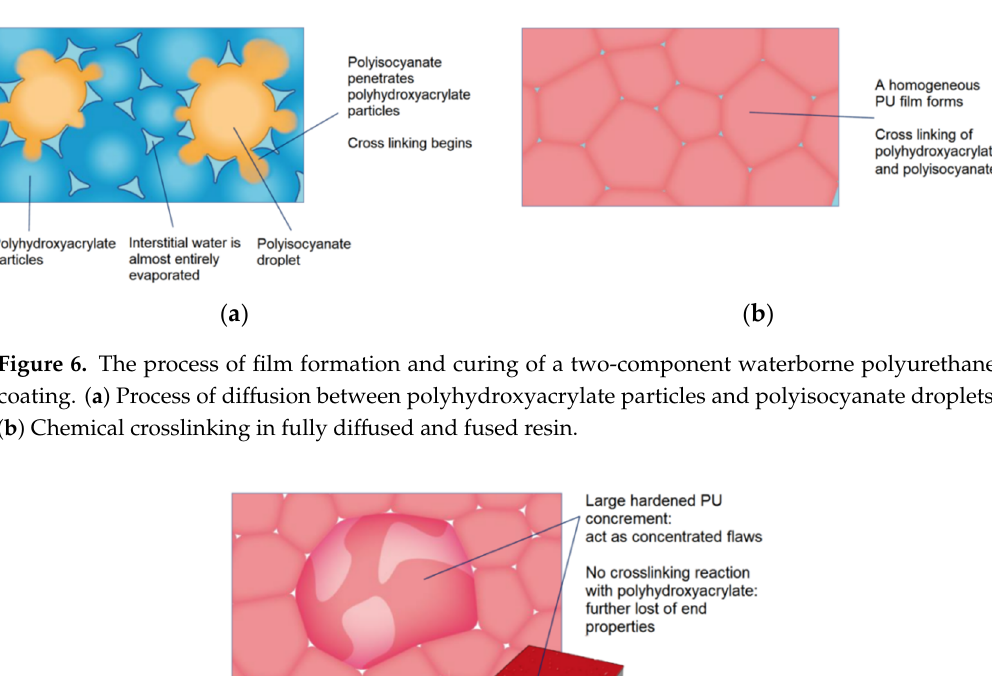
Figure 7. Chemical crosslinking reaction in resin with poor diffusion and fusion.